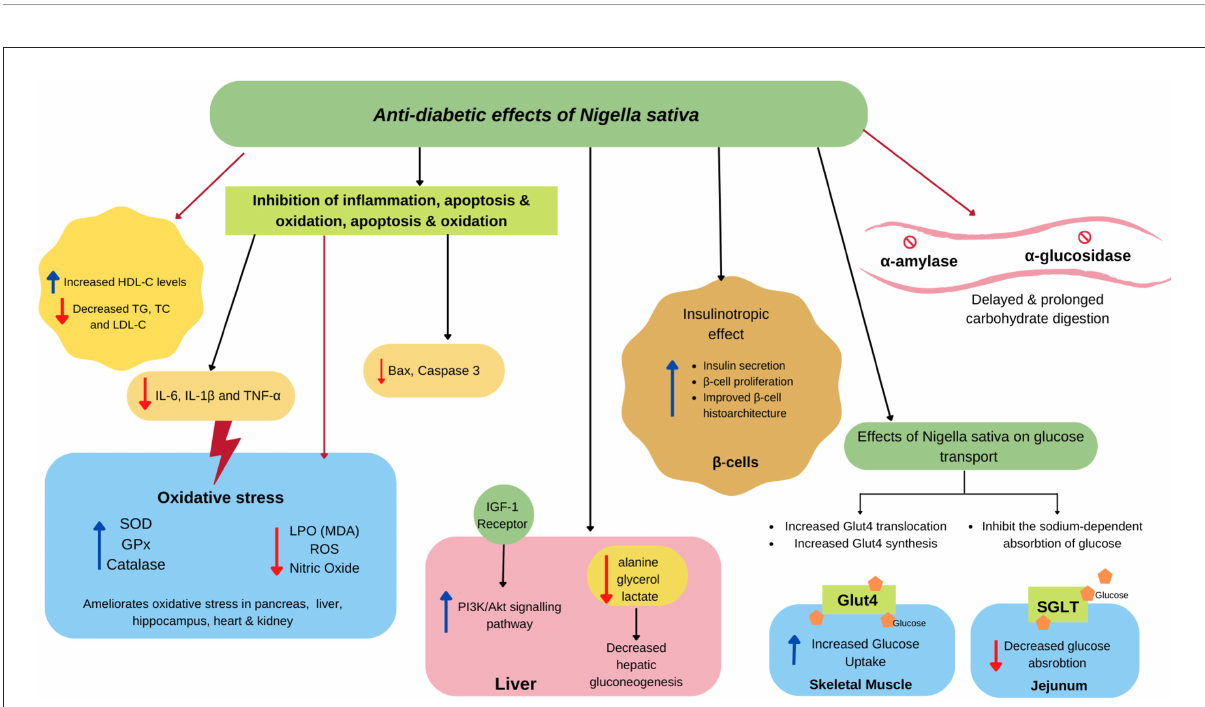
FIGURE3 Proposed antidiabetic effects of NS. NS attenuates insulin secretion by ameliorating β cell proliferation and improves the structure of the islet of the pancreas. In the small intestine, NS agents delay the digestion and absorption of food because of the inhibitory activity of α -amylase and α -glucosidase. NS also modulate SGLT causing less glucose absorption in the jejunum epithelium and activating GLUT4, which is associated with increased glucose absorption in skeletal muscle. NS also alleviates insulin resistance by activating the PI3K/Akt signaling pathway, which promotes GLUT4 biogenesis and translocation. NS also decreases hepatic gluconeogenesis by reducing its precursors. Besides, NS exerts a potential in scavenging O 2 − , HO · , DPPH, and other free radicals to lighten oxidative stress, resulting in the less production of malondialdehyde (MDA) and nitric oxide. NS also increase the contents and activity of antioxidant enzymes GSHPx, SOD, and CAT. NS improves dyslipidaemia, which could reduce inflammatory markers, such as IL-6, IL-1 β , and TNF- α , along with the reduction of apoptosis markers, such as Bax and